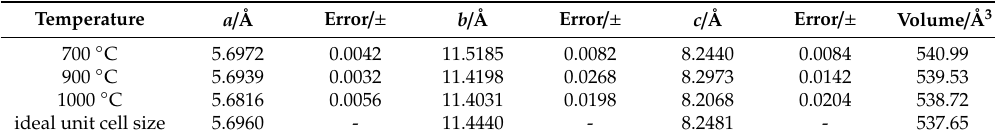
Table 4. Unit cell parameters of Mg 2 SiO 4 in nickel slag samples after oxidation at 700–1000 ◦ C. Temperature a / Å Error / ± b / Å Error / ± c / Å Error /